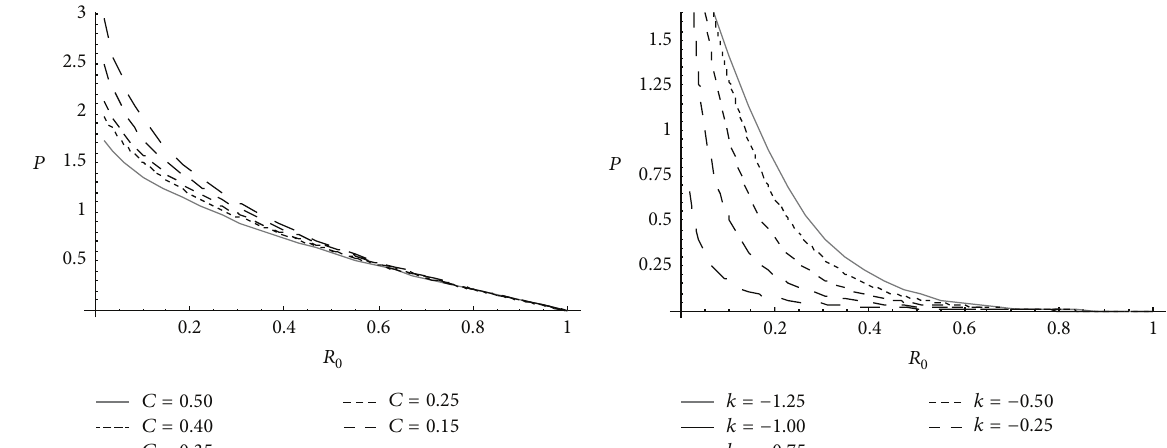
Figure 1: Effective pressure required for initial yielding for homogeneous and nonhomogeneous circular cylinder for different compressibility parameters.